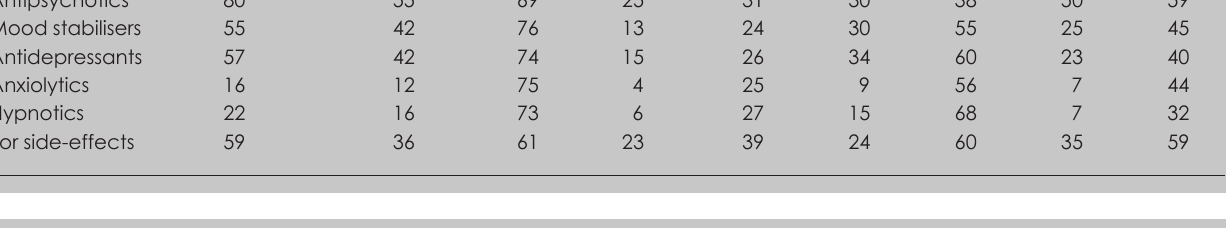
Medication category